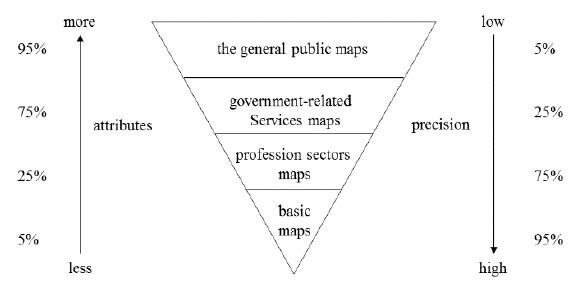
Figure 2.Analysis of changes in user requirements, with respect to accuracy and